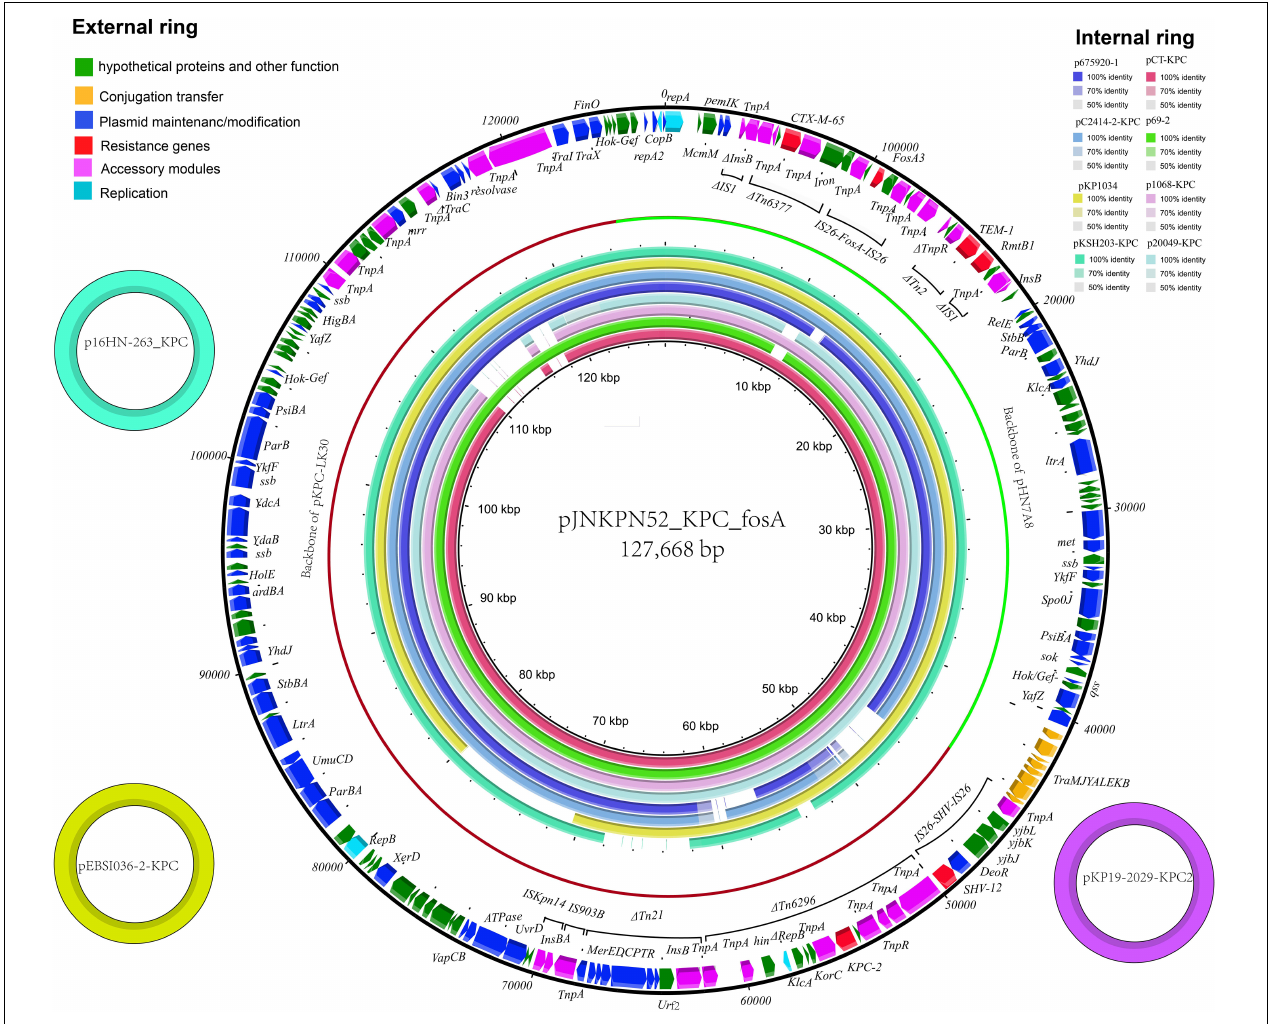
FIGURE 5 | The external ring is the main structural feature of plasmid pJNKPN52_KPC_fosA (GenBank accession no. MZ709016). The three small external rings display plasmids coharboring bla KPC − 2 and fosA with identity > 99%. The internal eight rings showed the comparative analysis of bla KPC -harboring plasmids with pJNKPN52_KPC_fosA (constructed by